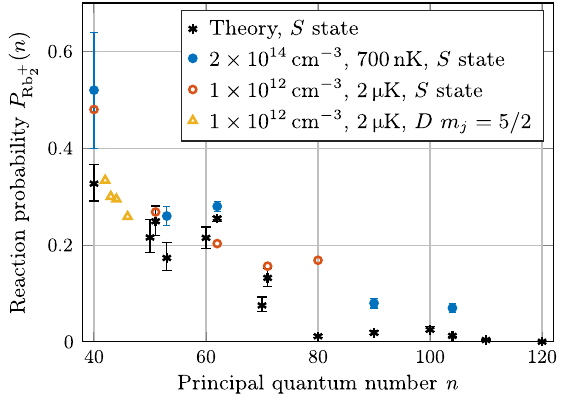
ð n Þ to create deeply bound FIG. 7. The probability P Rb 2 þ Rb þ 2 molecules is shown, calculated from the measured fraction ð n Þ ¼ N = of ionization events that produce Rb þ 2 P Rb 2 þ Rb 2 þ ð N þ N Þ . The delay time of the ionization in this experi- Rb þ Rb 2 þ ment is chosen such that almost all atoms experienced an inelastic collision. The blue error bars show the experimental uncertainty due to the finite electric field within the science chamber that drags away the molecular ions created. As a comparison, two data ¼ 5 = 2 [22]) from measurements of a sets ( S [16] and D , m j thermal cloud ( T ¼ 2 μ K) with a peak density of only 10 12 cm − 3 are added. The black dots represent the theoretical values for the probability of reaction by means of Eq. (6) and using the corresponding Landau-Zener probabilities. The error bars have been calculated from the errors shown in panel (b) of Fig.